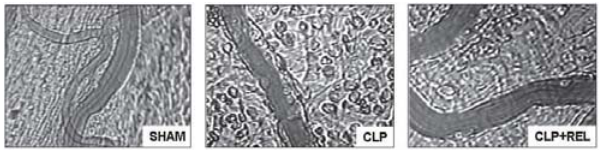
one place; 2, two places; 3, three places; 4, four places). Functional scores ranged from 2 (normal condition) to 15 (the most severe condition).